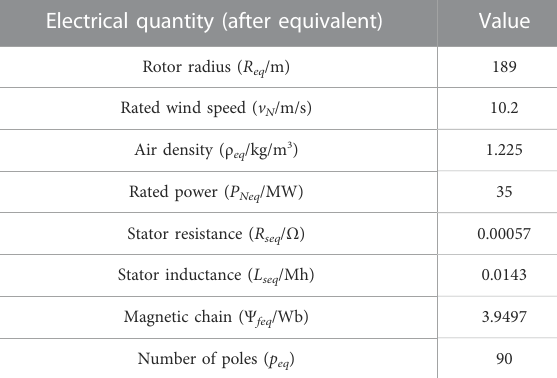
TABLE 3 Equivalent wind turbine parameters. Electrical quantity (after